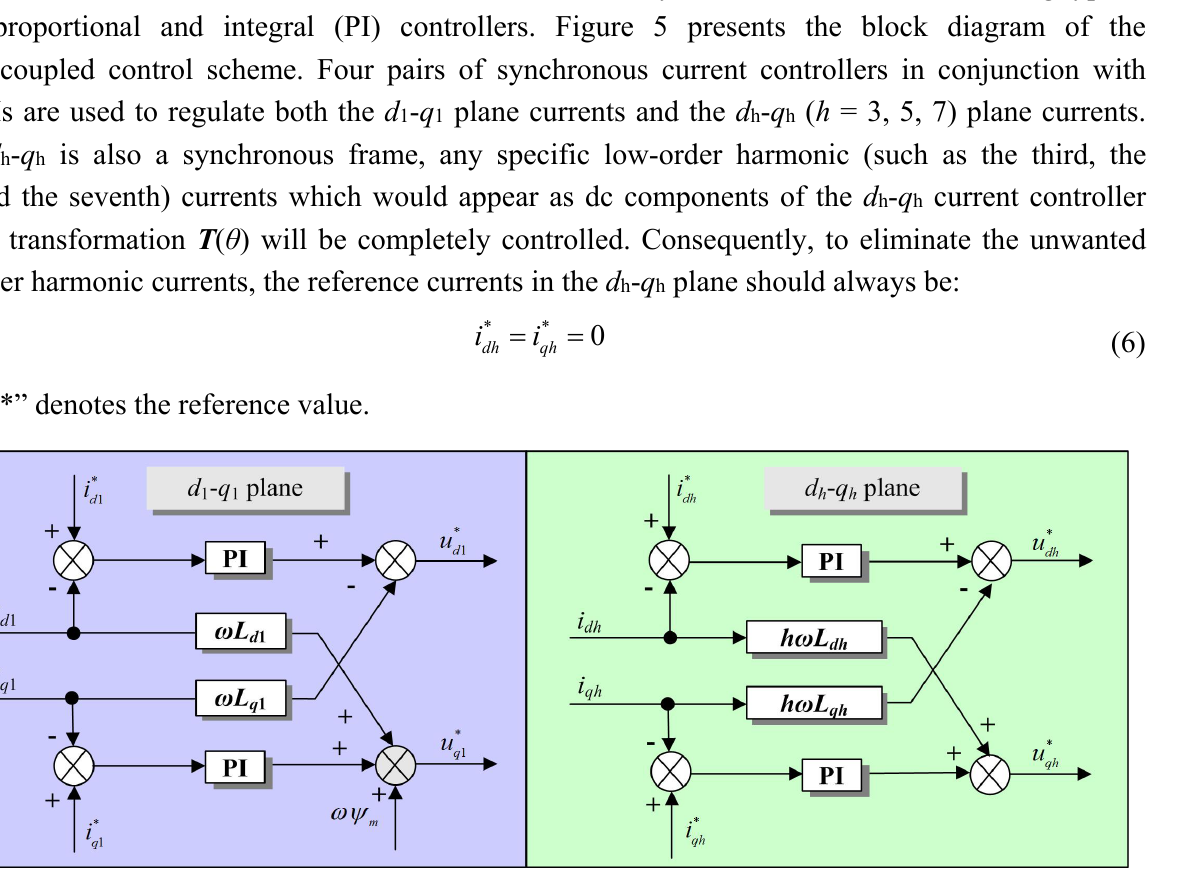
Figure 5. Fully-decoupled current control